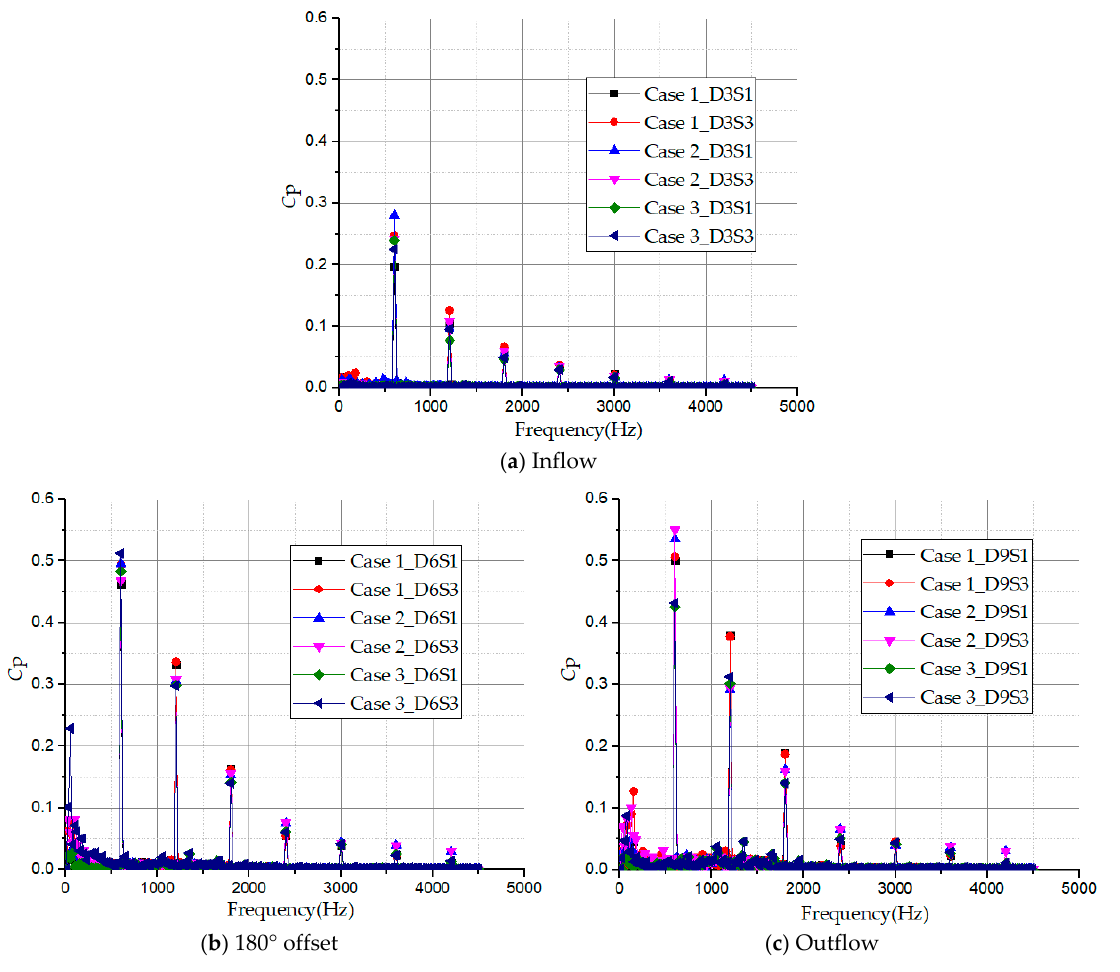
Figure 20. Frequency domain history of pressure fluctuation coefficient in side channel passage for three pump cases.